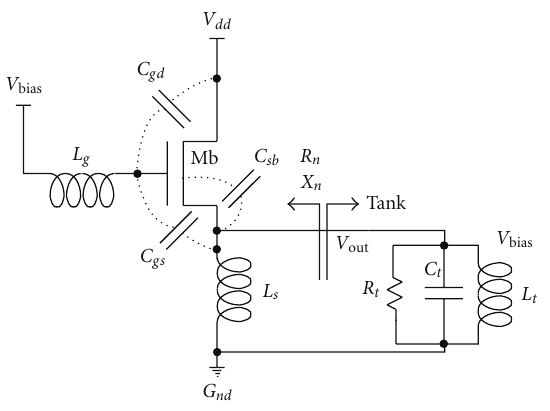
Figure 1: Proposed CMOS source follower bu ff er for negative resistance and MMW LC VCO